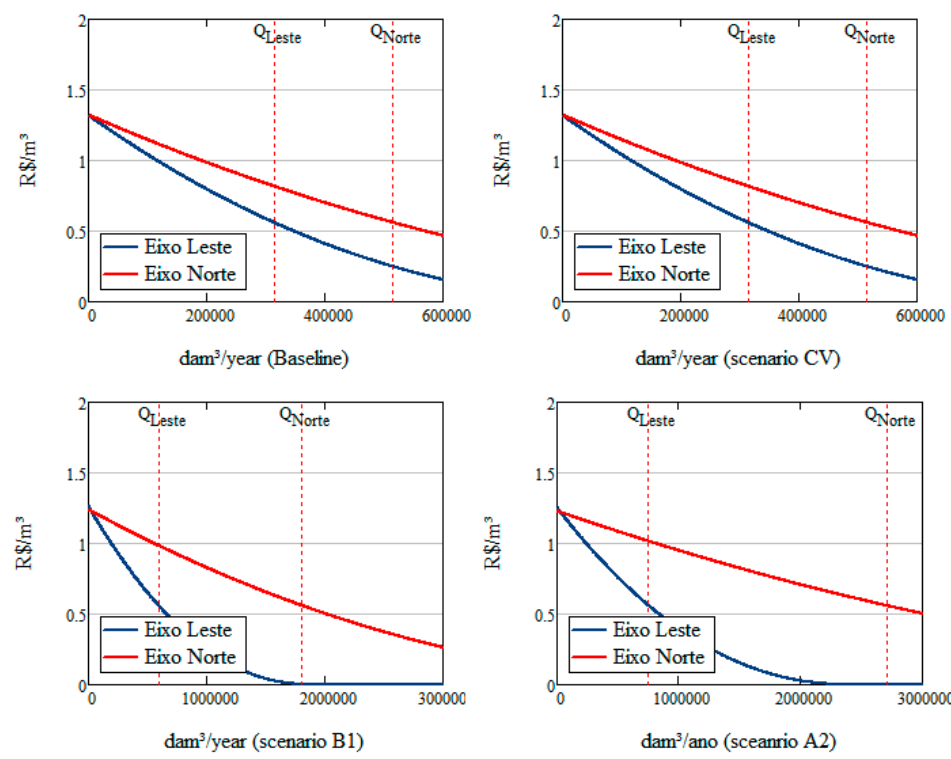
Figure 5. Marginal Benefits Curves for the PISF (transboundary project) under different scenarios (vertical dotted lines: upper bounds/water rights).